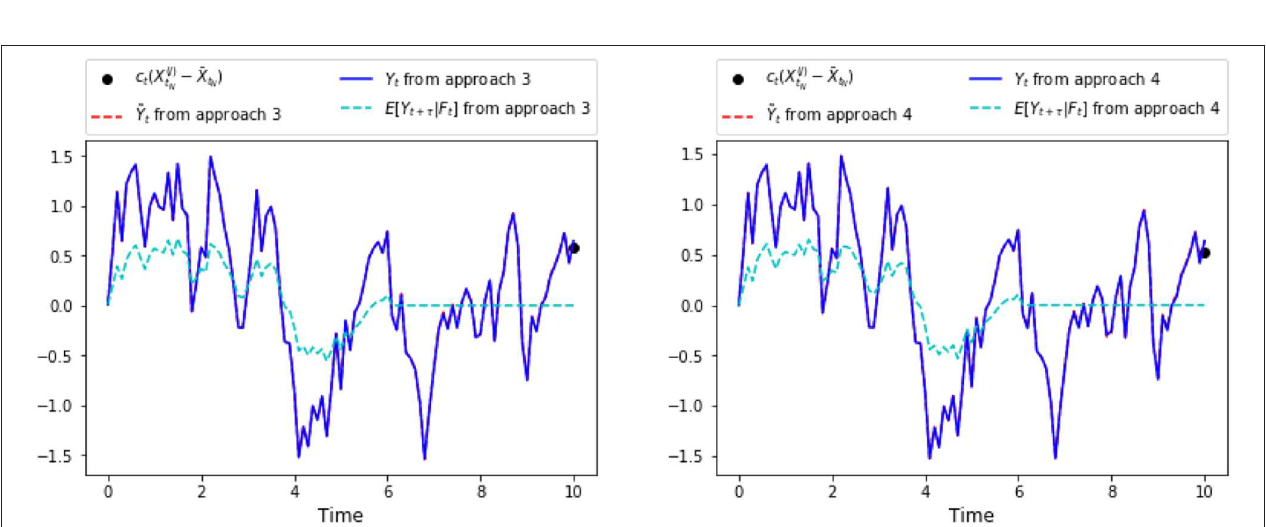
F t ) t ,( ˜ Y t ) t ,( E [ Y t ]) t ], from approach 3 (one the left) and from approach 4 (on the right). i i i + D | i 0 ≤ t i ≤ t N 0 ≤ t i ≤ t N 0 ≤ t i ≤ t N